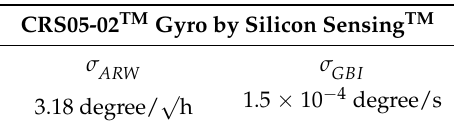
(TCZUPT filter). GBI